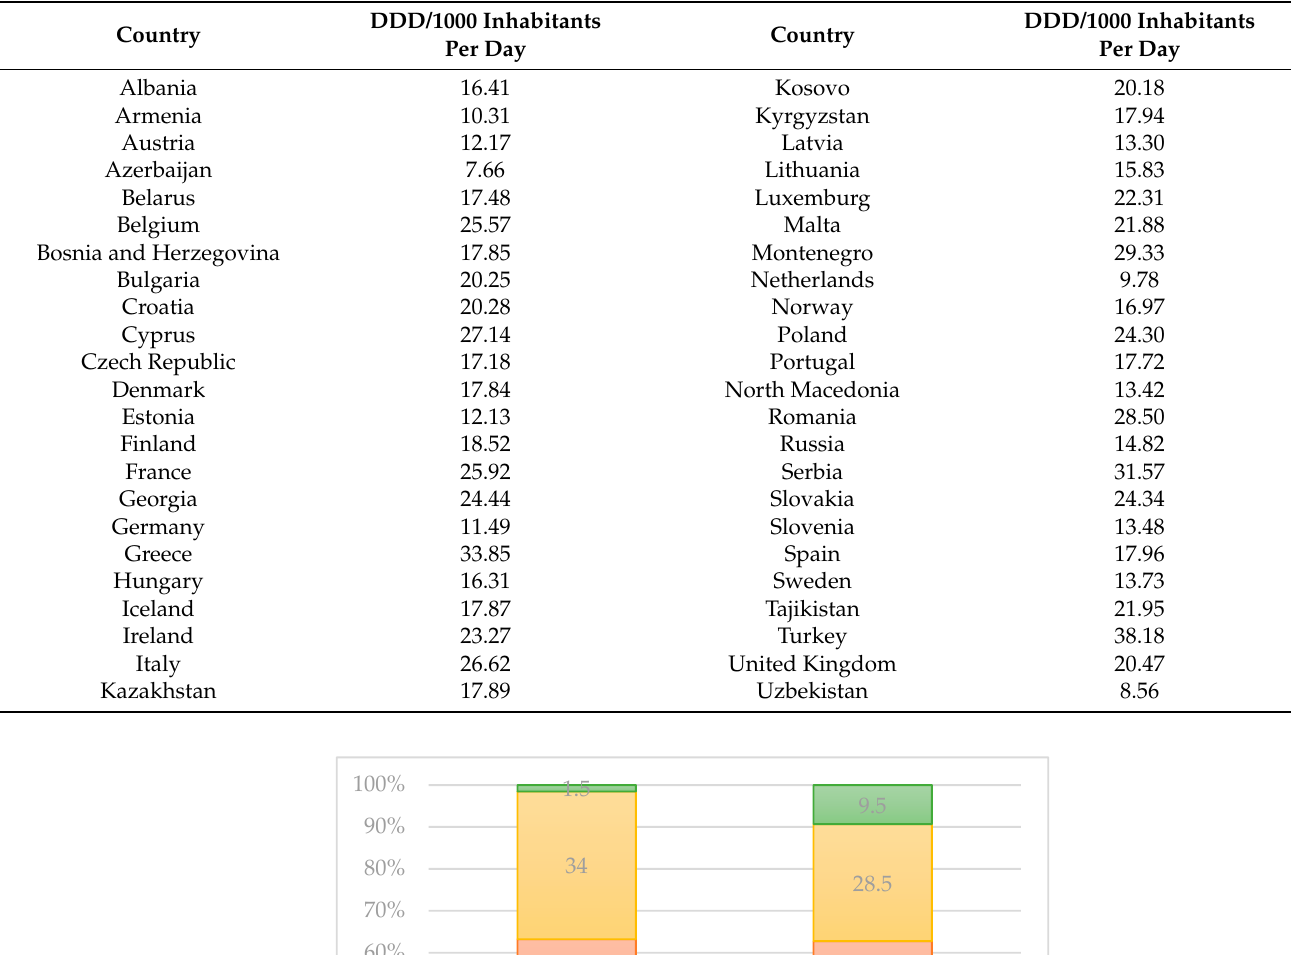
Table 1. The consumption of total antibiotics in Defined Daily Doses, in DDD per 1000 inhabitants per day in countries of European region based on WHO database [93].